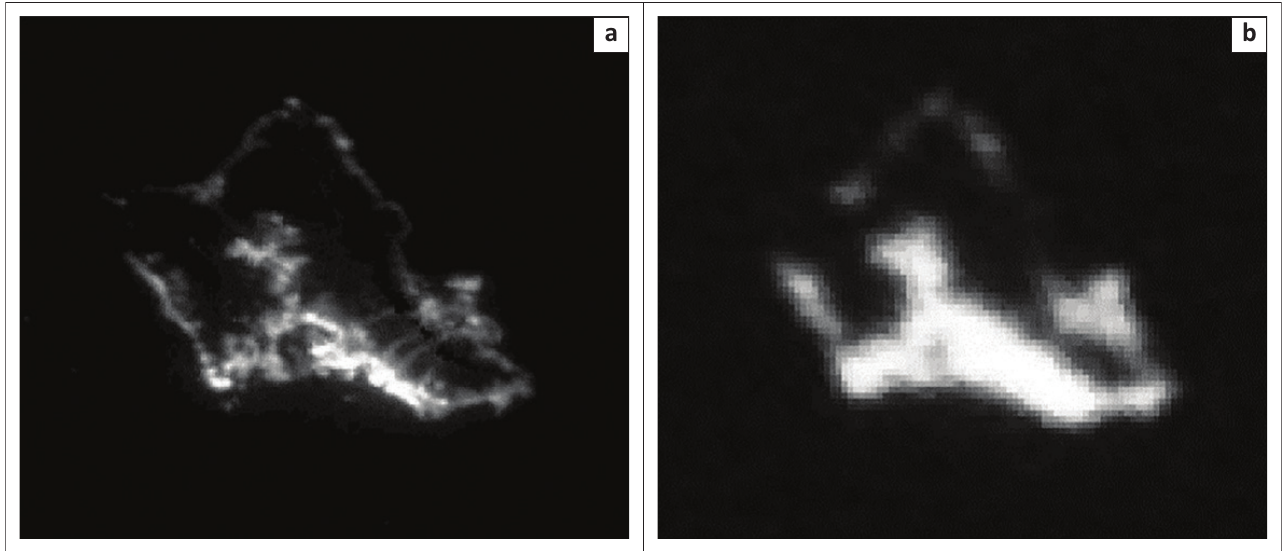
FIGURE 1: Suomi National Polar Partnership–Visible Infrared Imaging Radiometer Suite (a) versus Defence Meteorological Satellite Program–Operational Linescan System (b) cloud-free composited average visible band images of Oahu, Hawaii.